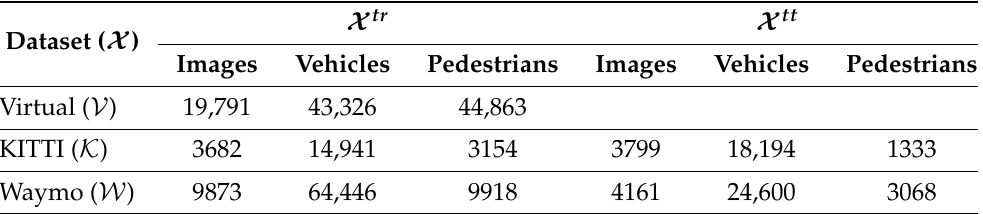
Table 2. Datasets ( X ): train ( X tr ) and test ( X tt ) statistics, X “ X tr Y X tt , X tr X X tt “ H . Dataset ( X